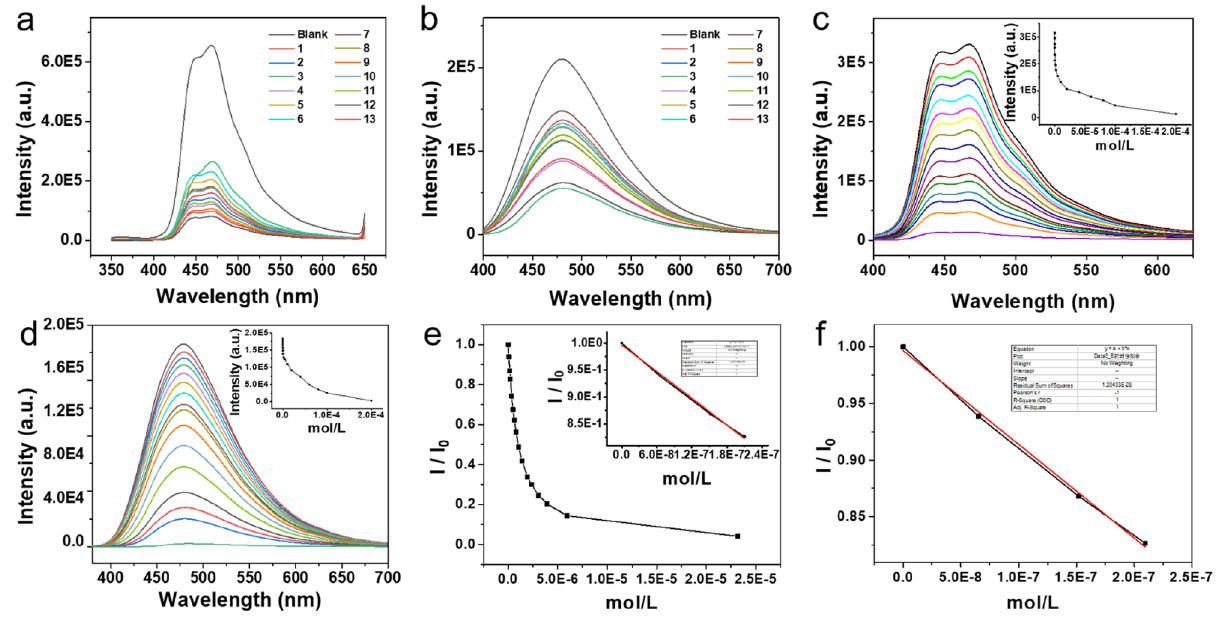
Figure 4. Fluorescence spectra [FPOP-SP] = 3 mg/mL (Ethanol/Water = 90/10) [Nitroaromatic compounds] = 2 × 10 –5 M. ( a ) ex = 330 nm, ex/em slits = 5/10 nm. ( b ) ex = 365 nm, ex/em slits = 5/5 nm. ( c ) ex = 330 nm, slits = 5/10 nm. ( d ) ex = 365 nm, ex/em slits = 5/5 nm ( e ) I and I 0 represent the fluorescence intensities of the suspension with and without nitroaromatic compounds added at a certain ratio. ex = 330 nm, slits = 5/10 nm. ( f ) Take data between 0–2 × 10 –7 linear fit was performed; ex = 330 nm, slits = 5/10